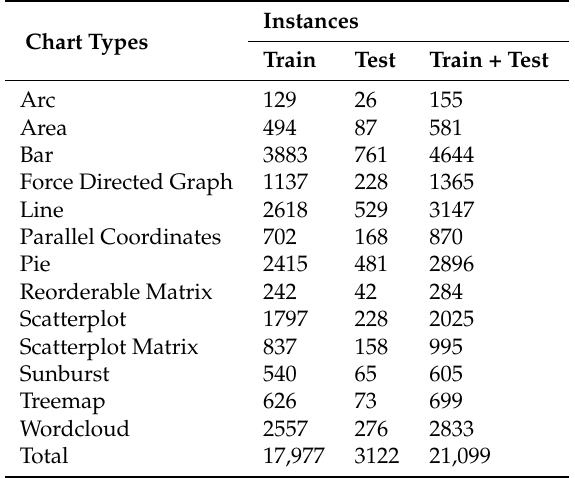
Table 1. Dataset summary, with train and test split by each chart type. This dataset is used throughout all steps, with modifications pertinent to each one of